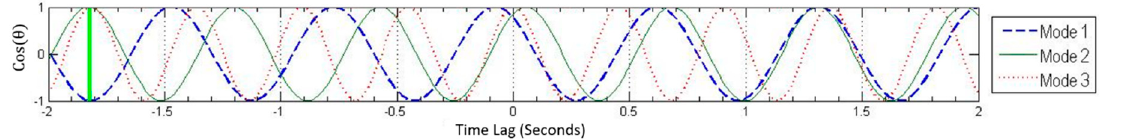
Figure 9. PATL plot for synchronized dataset for node #3. Notice the apparent lag in first and second modes result in the wrong solution. The correct solution should be at 0 s because data is synchro- nized.